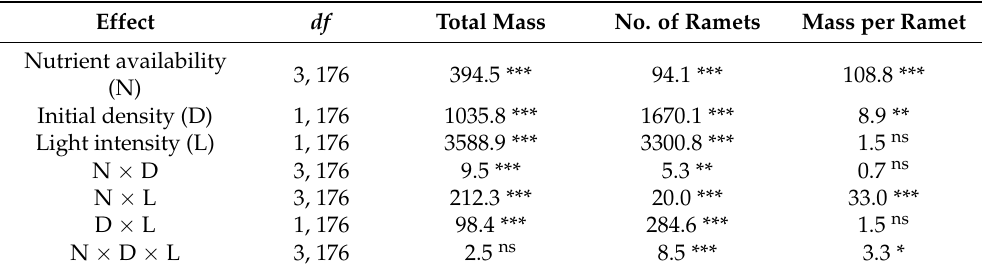
Table 2. Effects of nutrient availability, initial density and light intensity on total mass, number of ramets and mass per ramet of Spirodela polyrhiza for the first phase of Experiment 2.